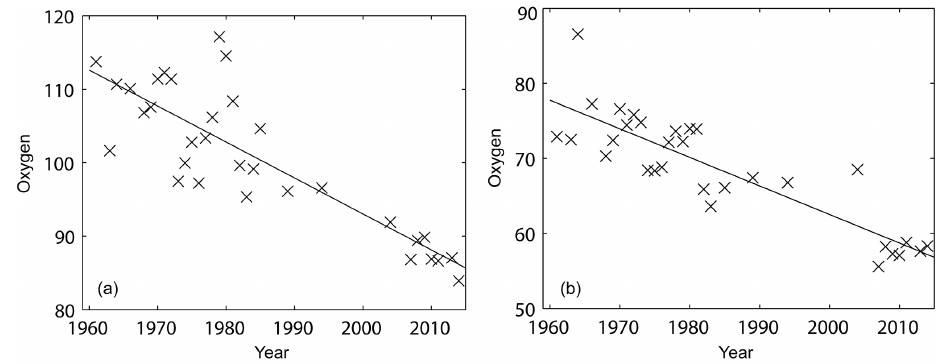
Figure 7. Mean dissolved oxygen concentration time series (µmolkg − 1 ) for the area 10–14 ◦ N, 20–30 ◦ W with a fitted linear trend and 95% confidence interval for (a) 100–300m ( − 0.49 ± 0.16µmolkg − 1 yr − 1 ) and (b) 300–700m ( − 0.35 ± 0.16µmolkg − 1 yr − 1 ).